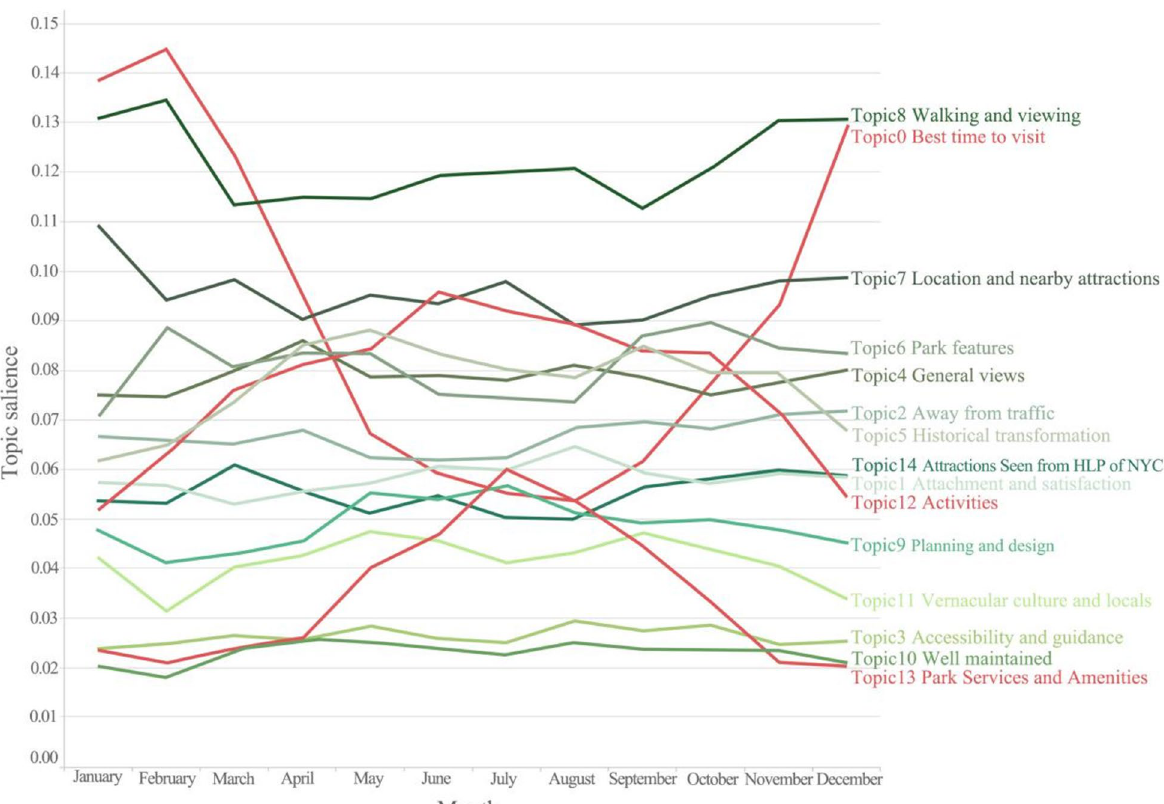
Fig. 8 The temporal patterns of topic salience